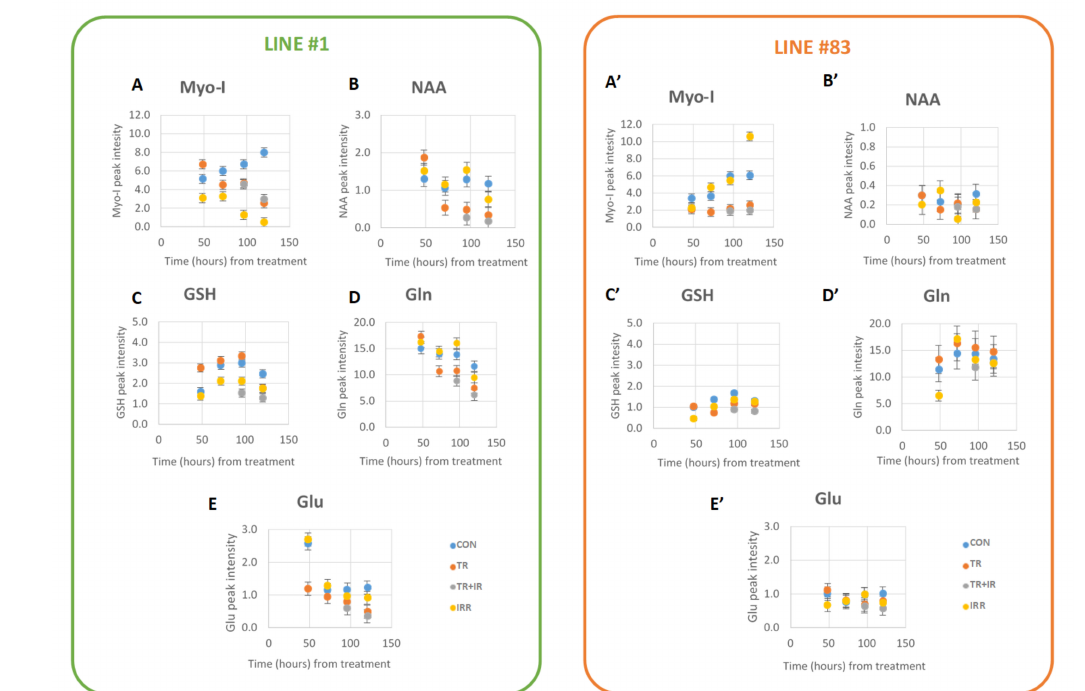
Figure 3. 2D COSY peak intensity of metabolic signals from Myo-I at 3.61–3.27 ppm ( A , A’ ), NAA at 2.67–2.48 ppm ( B , B’ ), GSH at 2.56–2.15 ppm ( C , C’ ), Gln at 2.44–2.13 ppm ( D , D’ ), and Glu at 2.35–2.10 ppm, ( E , E’ ) quantified in spectra from line #1 ( A – E ) and line #83 ( A’ – E’ ), respectively, as a function of time from ligand #190